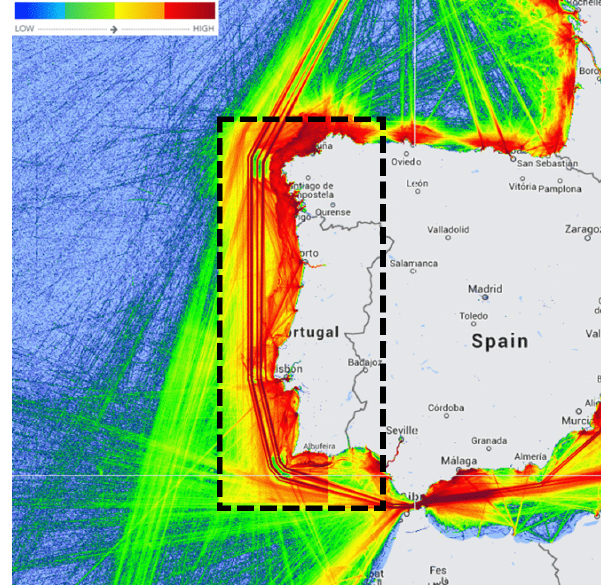
Figure 1. Ship density map around the pilot area in 2014. The white rectangle represents the area considered in this work to study the shoreline contamination risk in the Portuguese continental coast (source: